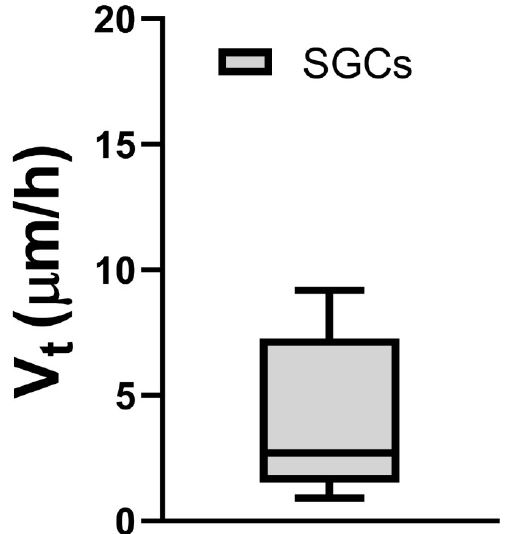
Figure 8. Migration velocity of SGCs. 3.3. Immunocytochemistry Evaluation The neurons and SGCs were differentiated by immunocytochemistry. The SGCs were identified by immunostaining for SK3, which has been used as a specific marker of SGCs in vivo , and βIII-tubulin, a typical neuronal marker, both in vivo and in vitro. More- over, DAPI staining contributed to differentiating the neurons and SGCs by nuclei sizes. For instance, neurons showed large and faintly stained nuclei, whereas SCGs exhibited small and bright nuclei. Immunocytochemistry revealed changes in SK3 staining over time (Figure 9A–C). The SK3 immunostaining was more intense at the early evaluation (4 h), decreasing at the subsequent stage (24 h), and then rising again during the last period of evaluation (48 h) (Figure 9A–C). A statistically significant difference was found in the quantification of the immunostaining during the study period (4 h vs. 24 h), as follows: 4 h and 24 h ( p < 0.0001), 4 h and 48 h ( p < 0.0001), and 24 h and 48 h ( p < 0.05). Figure 10 represents the SK3 fluorescence quantification. Figure 11 illustrates βIII-tubulin staining at 4 h (Figure 11A), 24 h (Figure 11B), and 48 h (Figure 11C). In addition, a double-staining was performed with SK3 and βIII-tubulin. The results showed a group of cells that were positive for both SK3 and βIII-tubulin. However, some cells were only stained with βIII- tubulin, while others were only stained with SK3. This pattern was found in all stages and is presented in the Supplementary Materials (Figure S1A–C). Figure 9. Anti-SK3 immunocytochemistry carried out in cultured TGCs (40× magnification), after 4 h ( A ), 24 h ( B ), and 48 h ( C ). SK3 was represented in red, while the nuclei (immunostained with